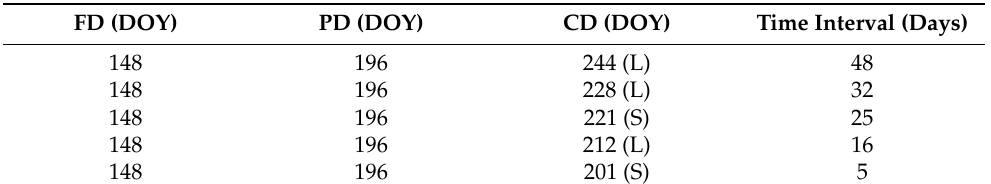
Table 1. Data selected for MLC period.